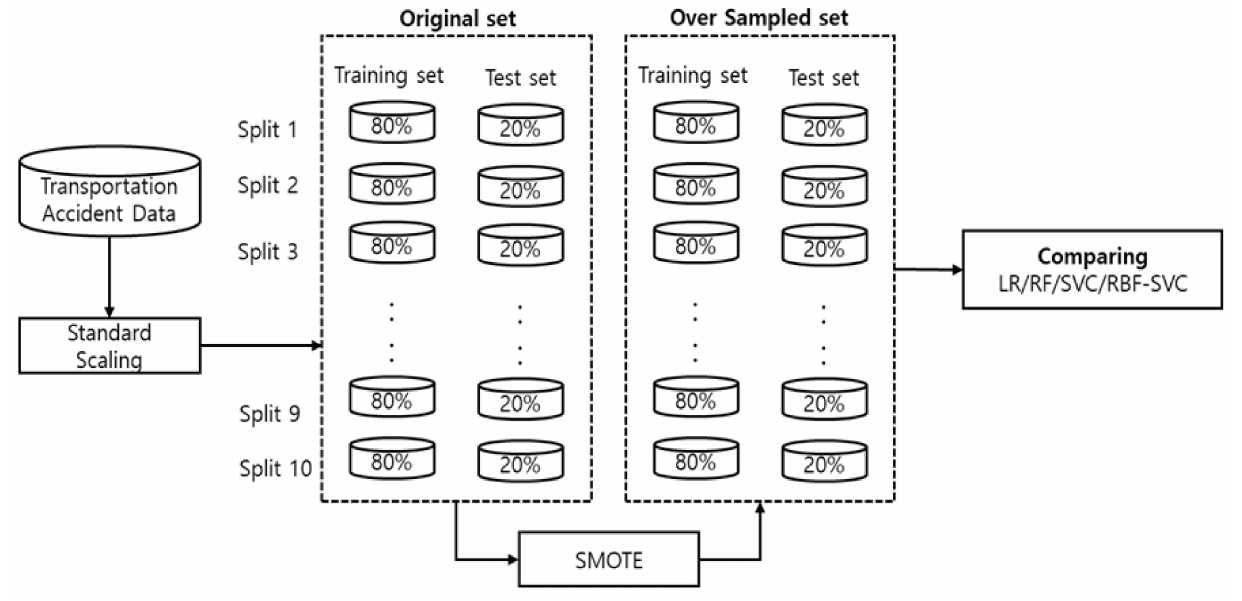
Figure 2. Sample data processing